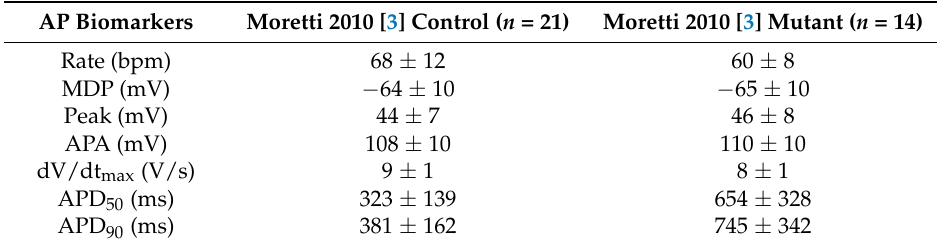
Table 2. AP biomarkers experimentally recorded in spontaneously beating control and mutant hiPSC-CMs in [3]. AP biomarkers are expressed as mean ± SD. APA: AP amplitude. APD 50 and APD 90 : AP duration at 50% and 90% of repolarization. dV/dt max : maximum upstroke velocity. MDP: